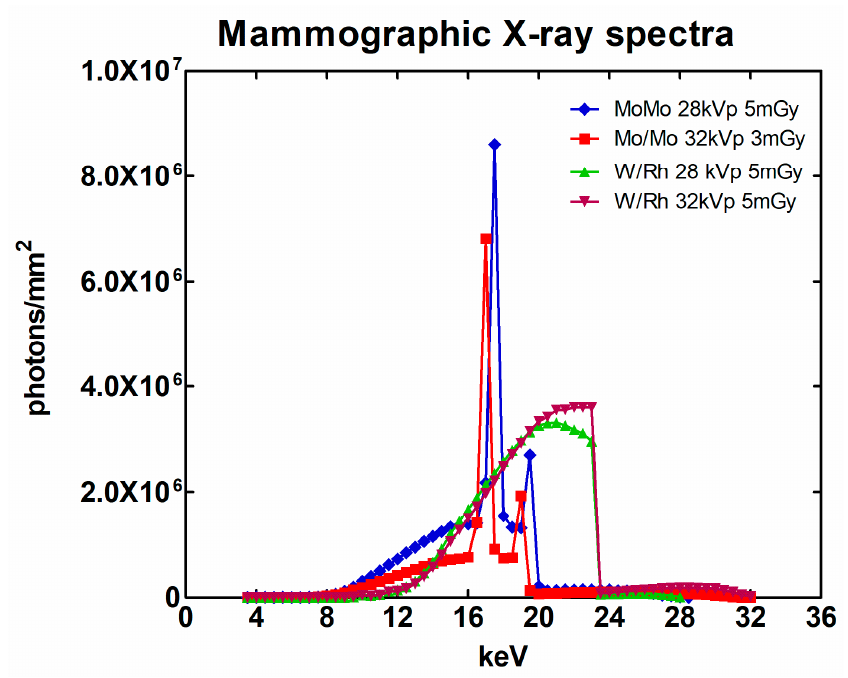
Figure 1. ( a ) The location of different lesion types on the mathematical phantom [30], and ( b ) the linear X-ray attenuation coefficients of the lesions. (Reference 30 is licensed under CC BY-NC-SA 4.0).